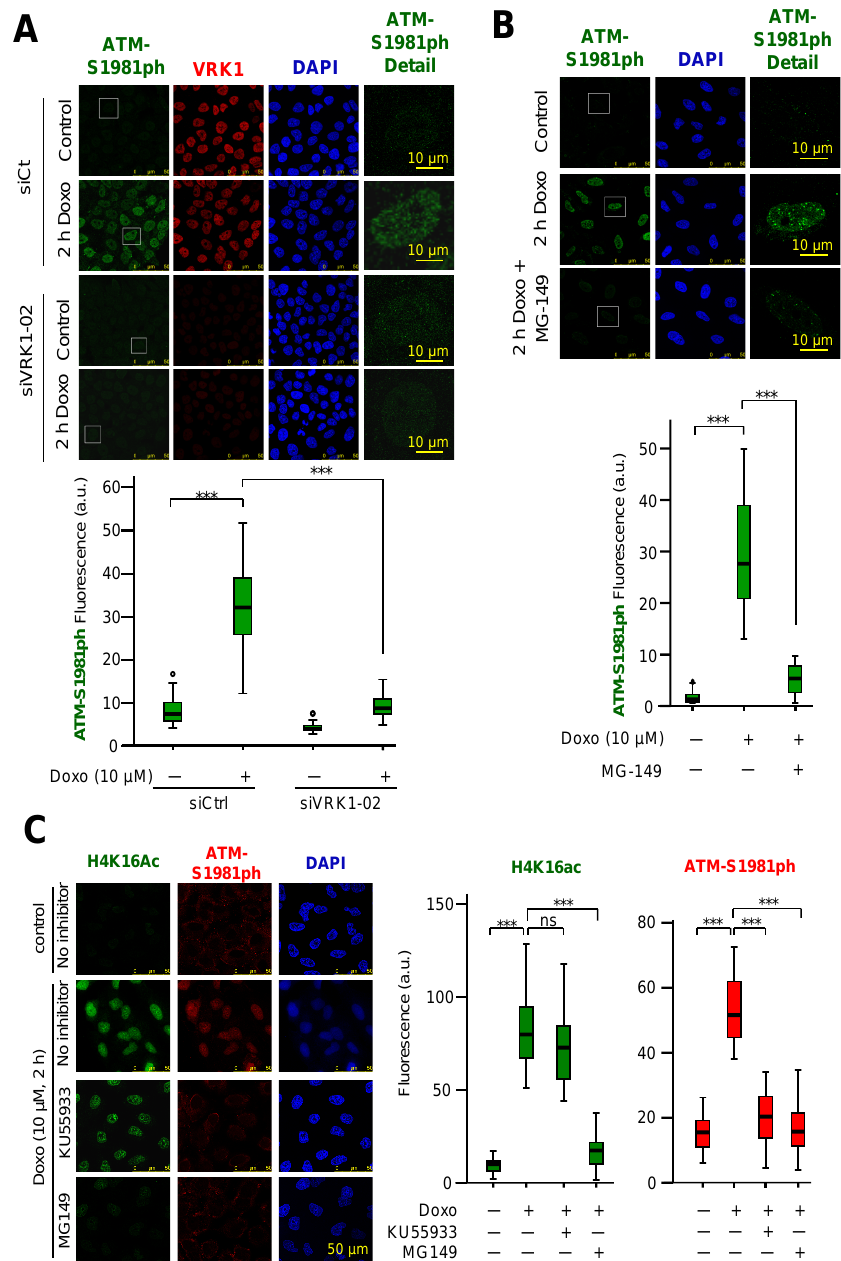
Figure 8. Phosphorylation of ATM is lost by depletion of VRK1 or inhibition of Tip60 in A549 (ATM +/+ ) cells. ( A ). E ff ect of VRK1 depletion or Tip60 inhibition on the phosphorylation of ATM in Ser1981. A549 cells deprived of serum (0.5% FBS) for 48 h were treated with doxorubicin and the e ff ect of VRK1 depletion on the phosphorylation of ATM was determined by immunofluorescence. Field images and the selected individual cell are shown in Figure S3A. ( B ). E ff ect of the inhibition of Tip60 with MG149 on the phosphorylation of ATM in Ser1981 induced by doxorubicin and detected by immunofluorescence. Field images and the indicated individual cell are shown in Figure S3B. ( C ). Di ff erential e ff ect of KU55933 (ATM inhibitor) and MG149 (Tip60 inhibitor) on the acetylation of H4K6 and ATM phosphorylation in A549 cells treated with doxorubicin. The graphs show the quantification of 50 cells. ns: Not significant. *** p < 0.001. All experiments were repeated three times. 2.8. The Kinase Activity of VRK1 is Necessary to Rescue ATM Acetylation and Phosphorylation